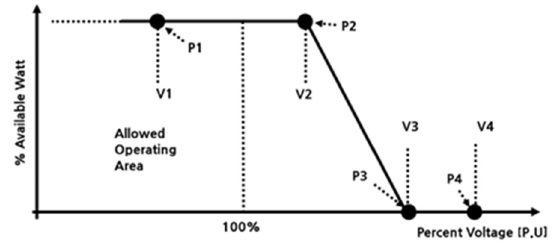
Figure 4. Illustration of a volt–watt control curve.